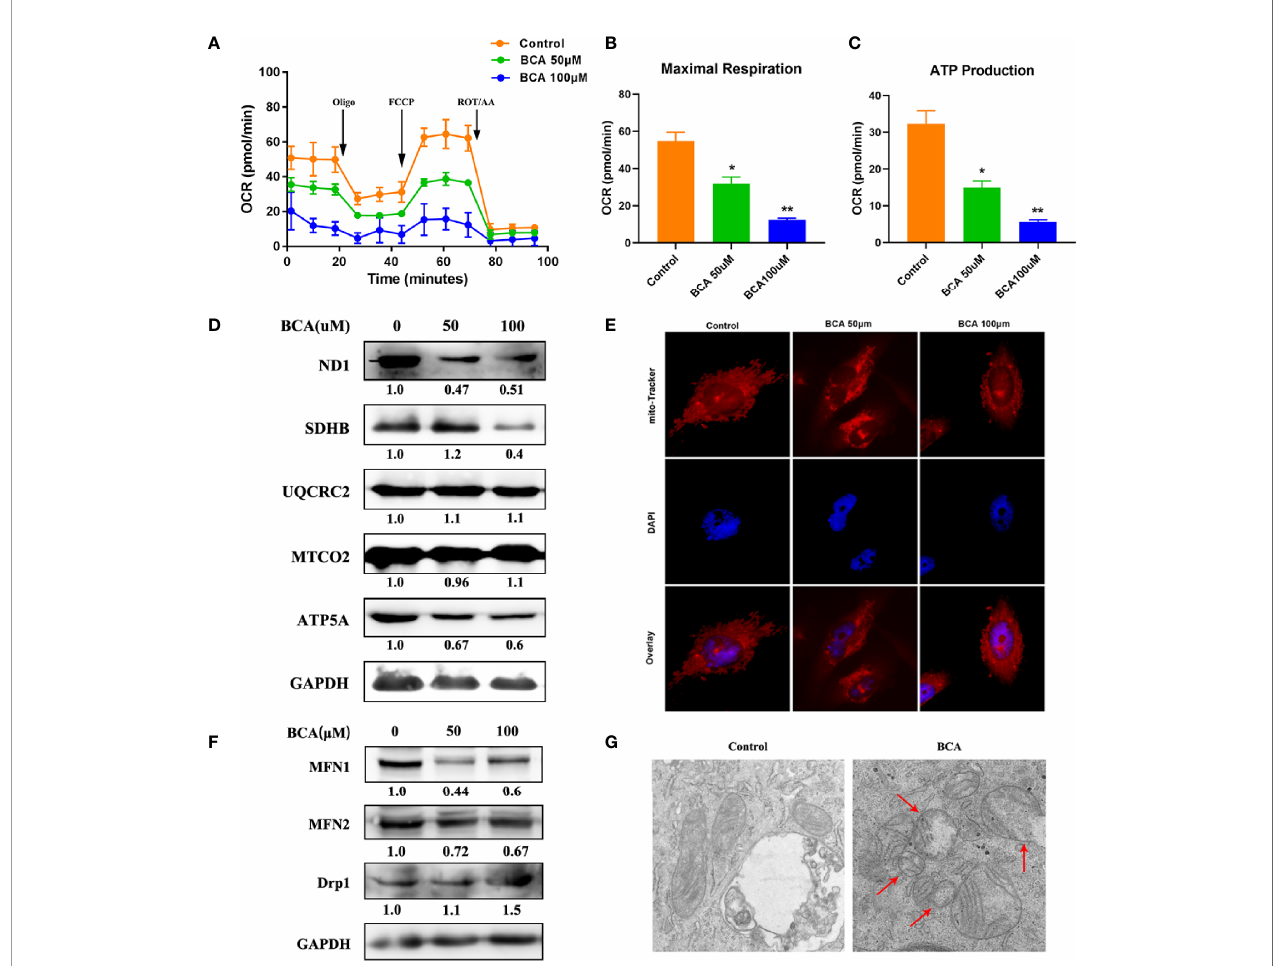
FIGURE 3 | BCA increases mitochondrial fi ssion and decreases mitochondrial oxidative phosphorylation. (A) Mitochondrial stress test to detect mitochondrial energy metabolism and respiratory functions in BCA (0, 50, 100 uM) group; (B) Quanti fi cation of the mitochondrial maximal respiration in A; (C) Quanti fi cation of the mitochondrial ATP production in A; (D) Western blot analysis the relative proteins of Mitochondrial respiratory chain (ND1, SDHB, UQCRC2, MTCO 2, ATP5A, and GAPDH). (E) Mitochondria morphology was observed by mito-Tracker staining; (F) Western blot analysis of the relative proteins of mitochondrial fusion division (MFN1, MFN2, and Drp1); (G) The morphology of mitochondria was observed by transmission electron microscope in control and BCA group. *P < 0.05, **P < 0.01 versus